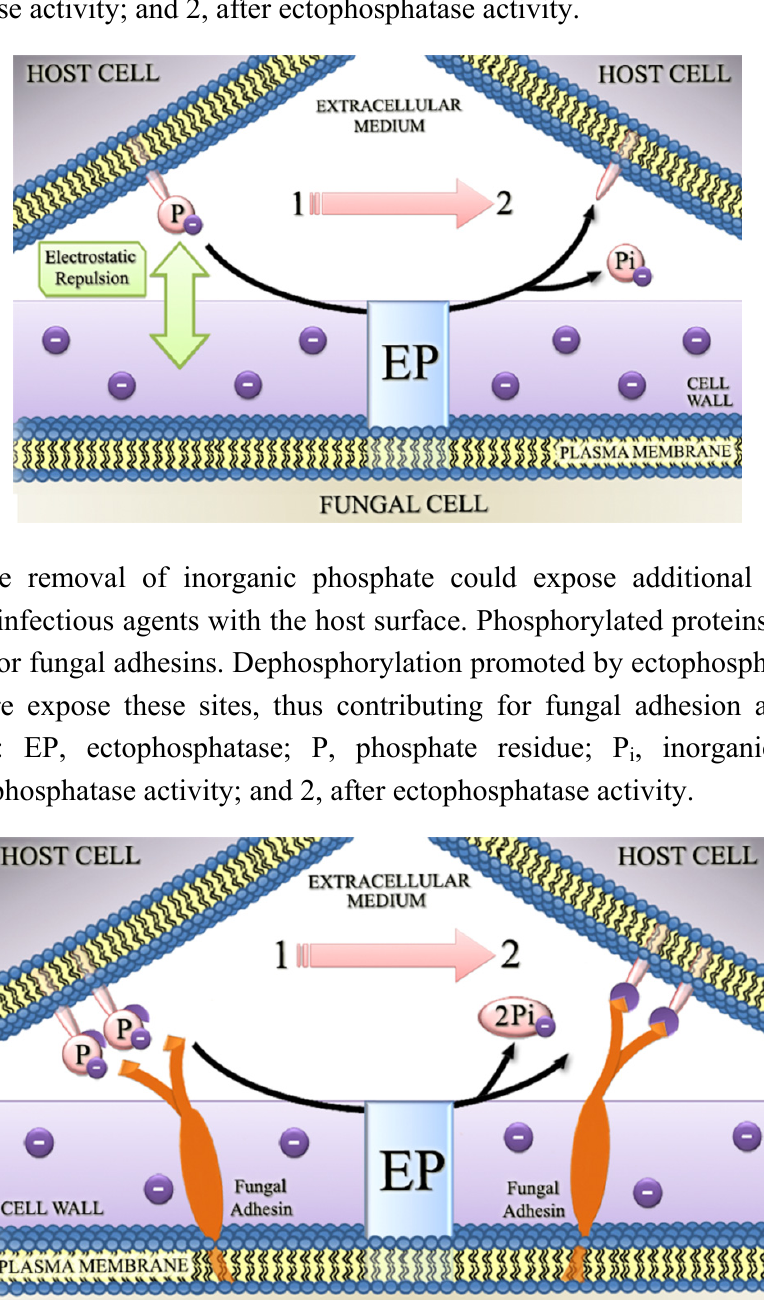
Figure 1. The removal of phosphate groups from surface proteins in host cells could result in attenuation of the electrostatic repulsion between fungal and host cells. The fungal cell surface is electronegative and the presence of phosphate residues on the surface of the host cell increases the electrostatic repulsion between them. Ectophosphatases may contribute to the success of fungal infection by removing phosphate residues of the host cell plasma